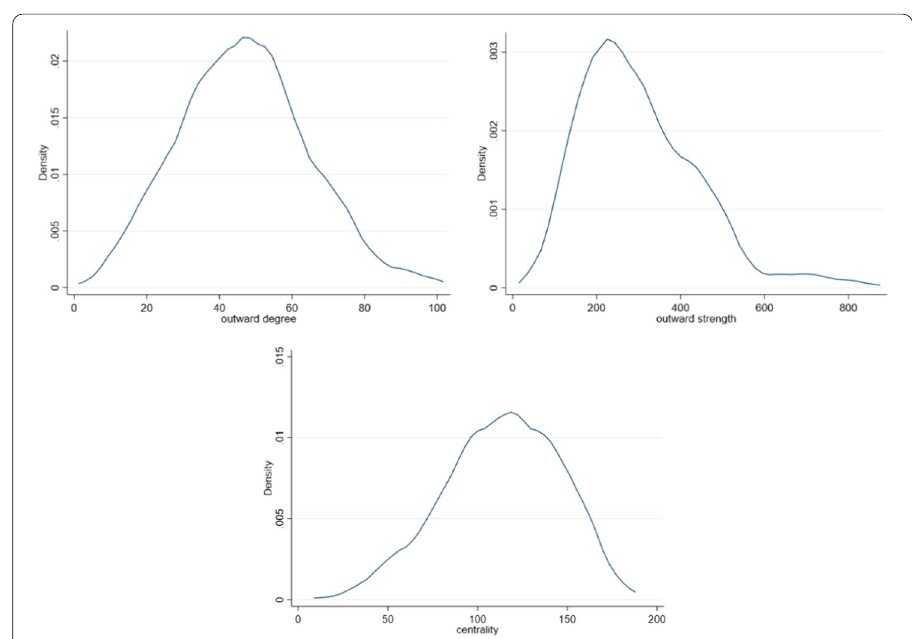
Fig. 3 Distribution of nodes centrality indexes. Note : The Figure displays the distribution of nodes (occupations) according to several outcomes: outward degree (upper left), outward strength (upper right) and centrality (lower